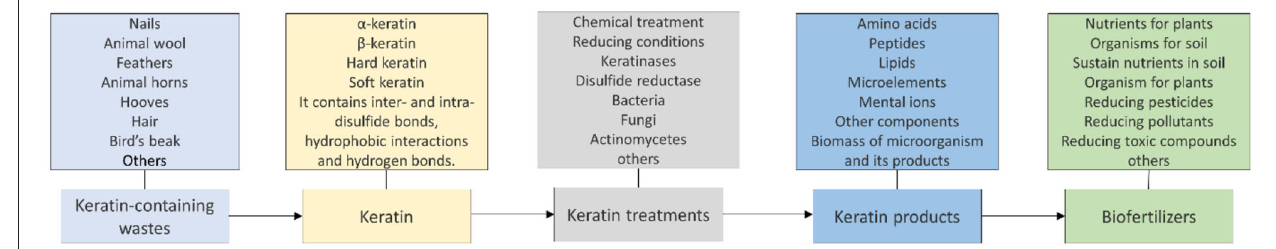
FIGURE 4 | Keratin and its potential to be converted into biofertilizers. The source of keratin and its conversion to biofertilizers are listed. Keratin-containing wastes, structures of keratin, methods for keratin treatment, keratin products, and application of biofertilizers are indicated.